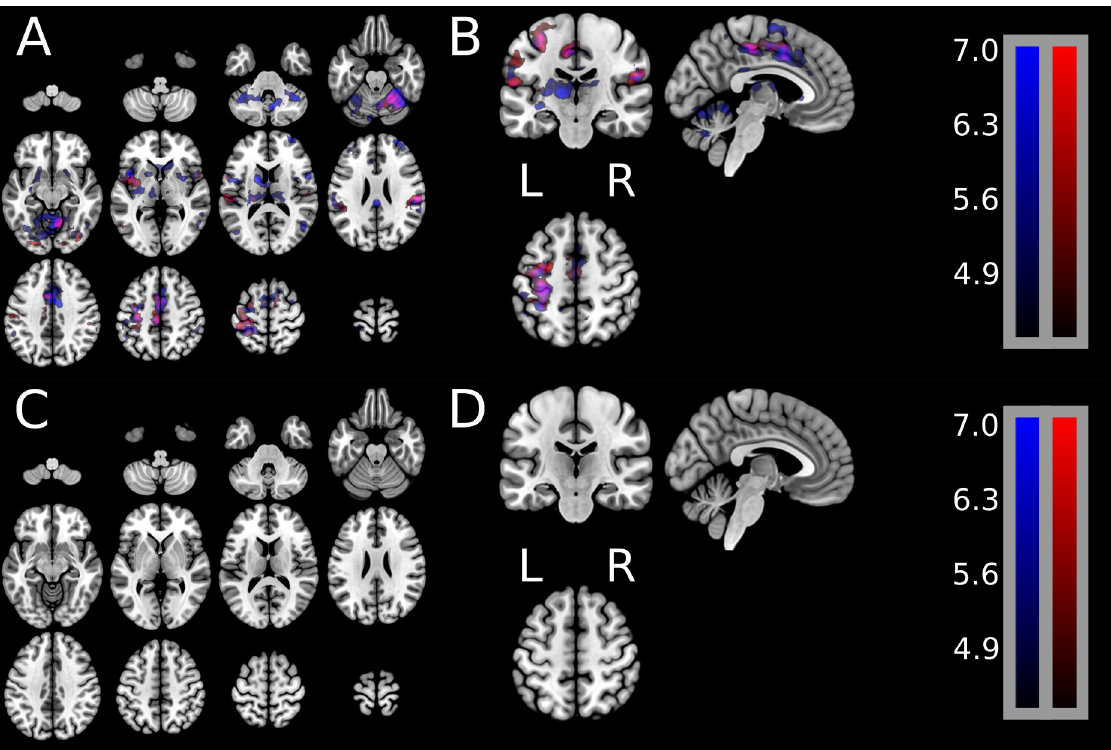
Fig 3. Group-level GLM activation maps showing unique brain activation spatial patterns during the wrist extension movement (red), unique activation during wrist flexion movement (blue), and shared activation patterns during extension and flexion. Group-level t- statistic images were created in MNI coordinates for the following contrasts: Wrist extension versus rest, wrist flexion versus rest, and wrist flexion versus wrist extension. Panels A and B show one statistical map containing unique brain activations during wrist extension only (red) and unique activations during wrist flexion only (blue), as well as brain activations shared in common during extension and flexion. t- statistic images were assessed for cluster-wise significance using a forming threshold corresponding to p < 0.001. Critical cluster sizes were 702 mm 3 and 945 mm 3 for wrist extension and wrist flexion, respectively. Panels C and D illustrate the lack of results from calculating the statistically significant difference of greater brain activation during extension versus that during flexion. Fig 3, Panels C/D shows that no regions (no red or no blue regions) survived the statistical significance